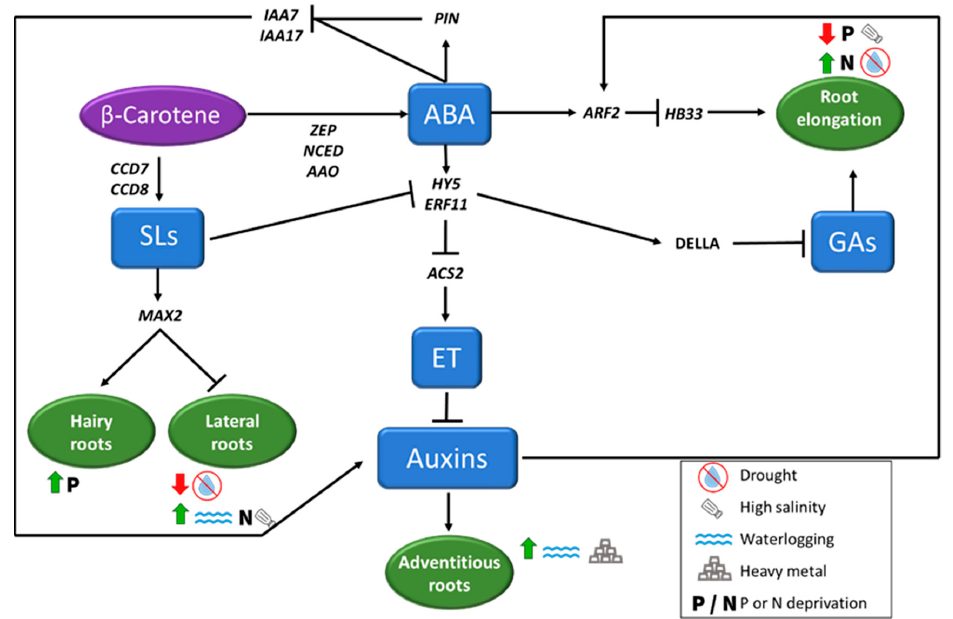
Figure 4. Root architecture (considering root elongation, and hairy, lateral, and adventitious roots formation) under abiotic stress conditions is regulated by phytohormones, that induce or repress the process depending on the adverse condition. Abscisic Acid (ABA) plays a key role in regulating root cell elongation in different ways, repressing Gibberellins (GAs) through an increase of DELLA proteins concentration or inhibiting auxins biosynthesis. Auxins and Strigolactones (SLs), also play important role in root architecture, inducing or repressing the formation of new roots depending on the adverse environmental situation, as indicated in the figure.